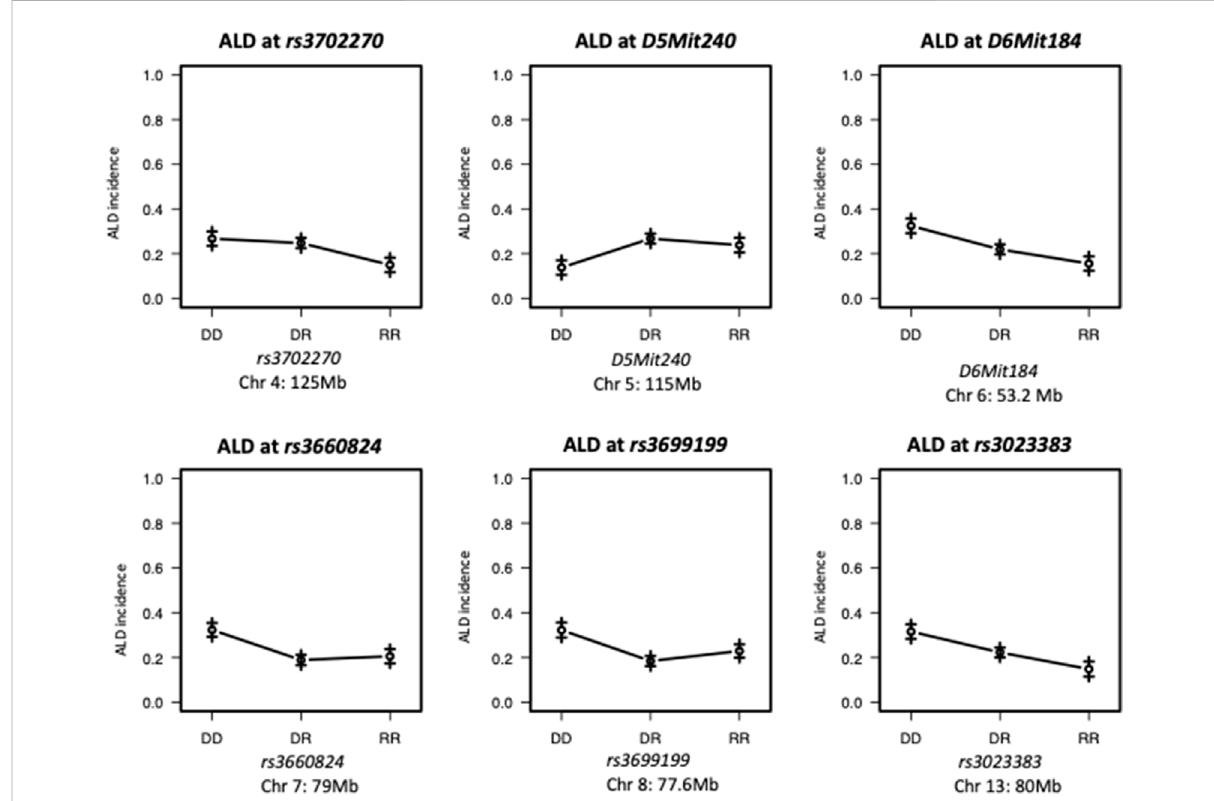
FIGURE 2 Effect Plots of markers on the peak of each chromosome. ALR allele on Chromosome 4 and 7 recessively contributes to resistance; ALR allele onChromosomes8dominantlycontributestoresistance.ALRallele onChromosome5dominantlycontributes tosusceptibility; OnChromosomes 6 and 13, the susceptibility contributed by NOD allele and resistance contributed by ALR allele co-dominantly exist. DD: homozygous for NOD; DR: heterozygous for NOD and ALR; RR: homozygous for ALR.